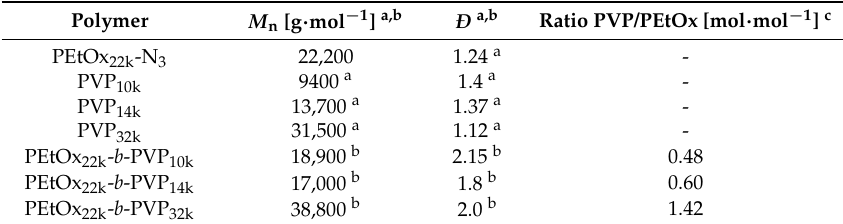
Table 1. Results of polymerizations and block copolymer formations.